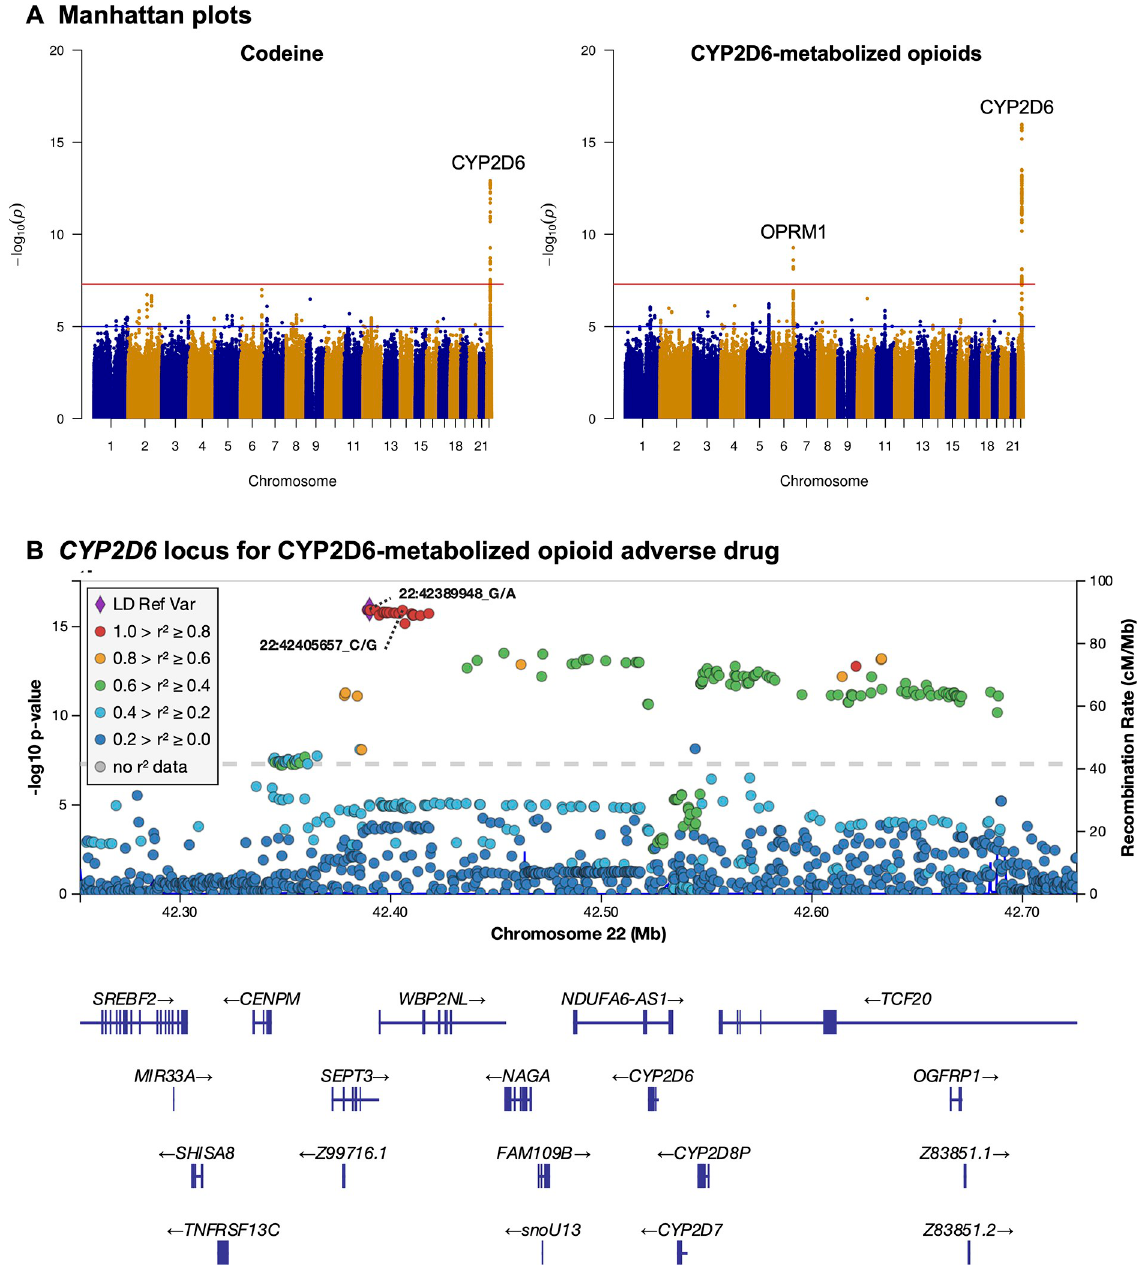
Fig 1. A) Manhattan plots of genome-wide association studies (GWAS) for codeine (left) and CYP2D6-metabolized opioid (right) adverse drug reactions (ADRs). Red lines on Manhattan plots show the genome-wide significance level ( P < 5.0 × 10 − 8 ). B) CYP2D6 locus for CYP2D6-metabolized opioid ADRs. SNPs are colored according to their linkage disequilibrium (LD, based on 1000 Genome phase3 EUR reference panel) with the lead variant rs739296 (22:42389948), which is marked with a purple diamond. The lead variant rs9620007 (22:42405657) for codeine ADRs is also labeled. Dotted gray line shows the genome-wide significance level ( P < 5.0 × 10 − 8